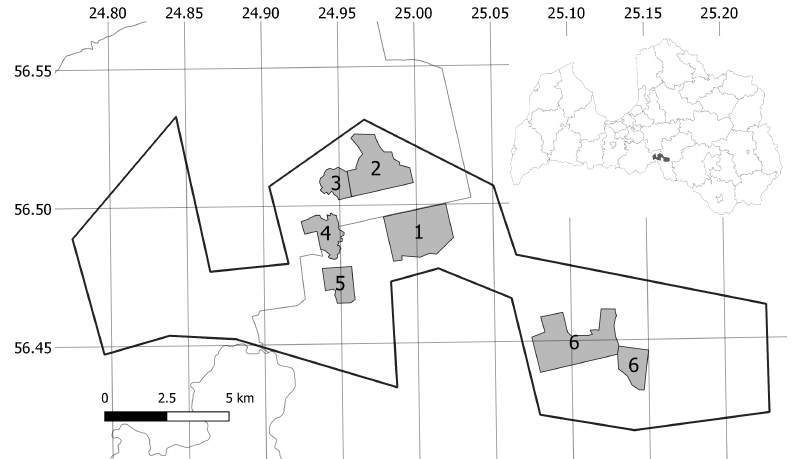
Figure 1. Study site and six sample plots that were employed for additional reference data acquisition. Centre coordinates 56.46 ◦ N, 25.04 ◦